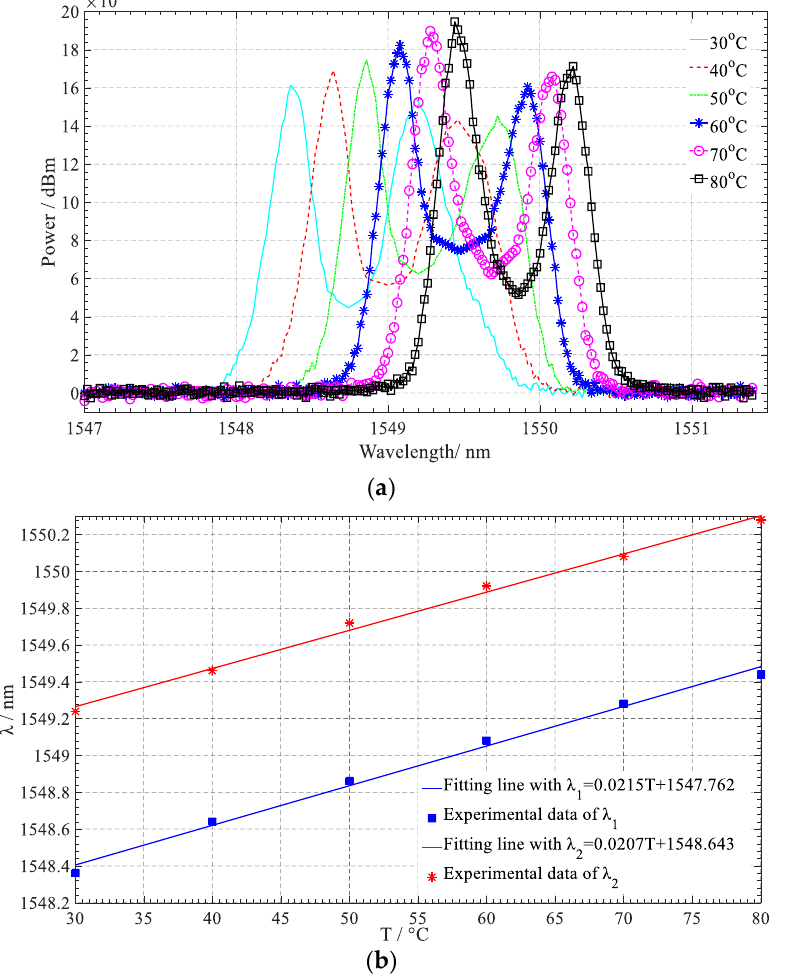
Figure 6. Temperature sensing of Type C ( a ) spectra at 30 to 80 °C ( b ) temperature sensitivity.